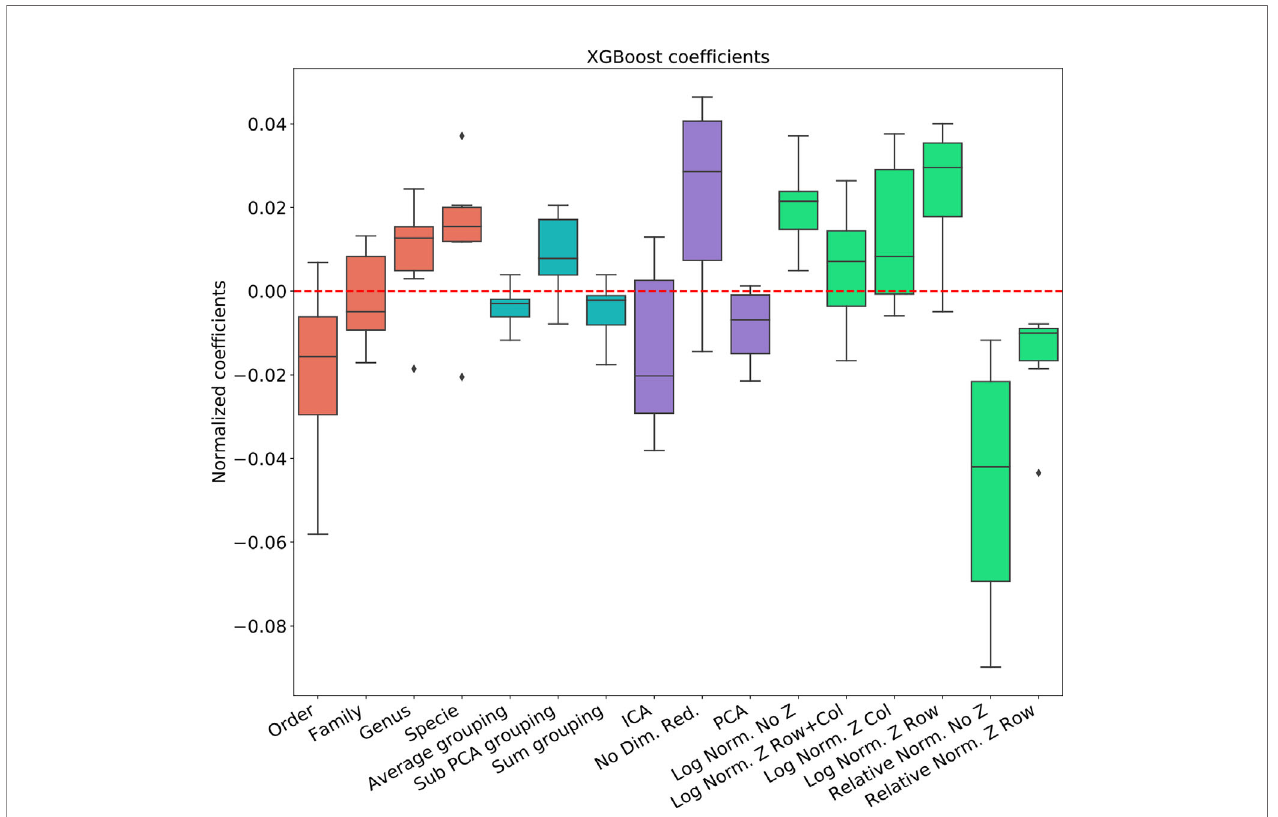
FIGURE 4 | Linear regression coef fi cient for XGBosot classi fi